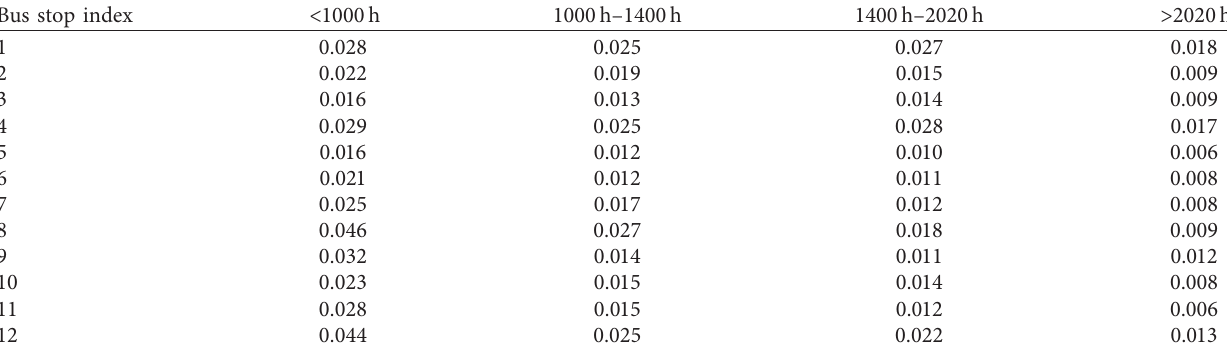
Table 1: Mean passenger arrival rate λ j at different times of the day. The unit is given by the number of passengers per second. j at bus stop Bus stop